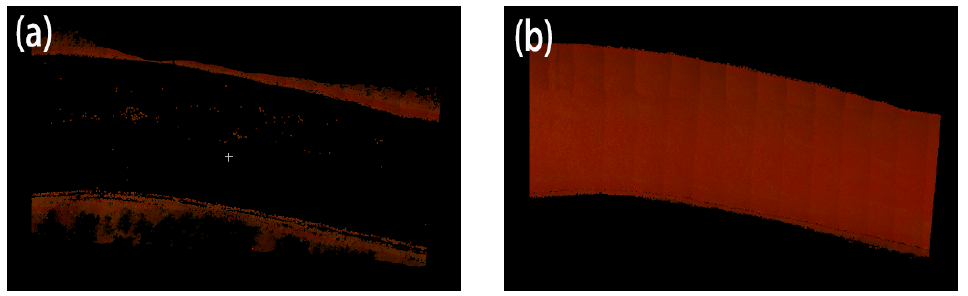
Figure 28. The ski-track was extracted from the Figure 24 b : ( a ) is non-ski-track points; ( b ) is ski-track points.